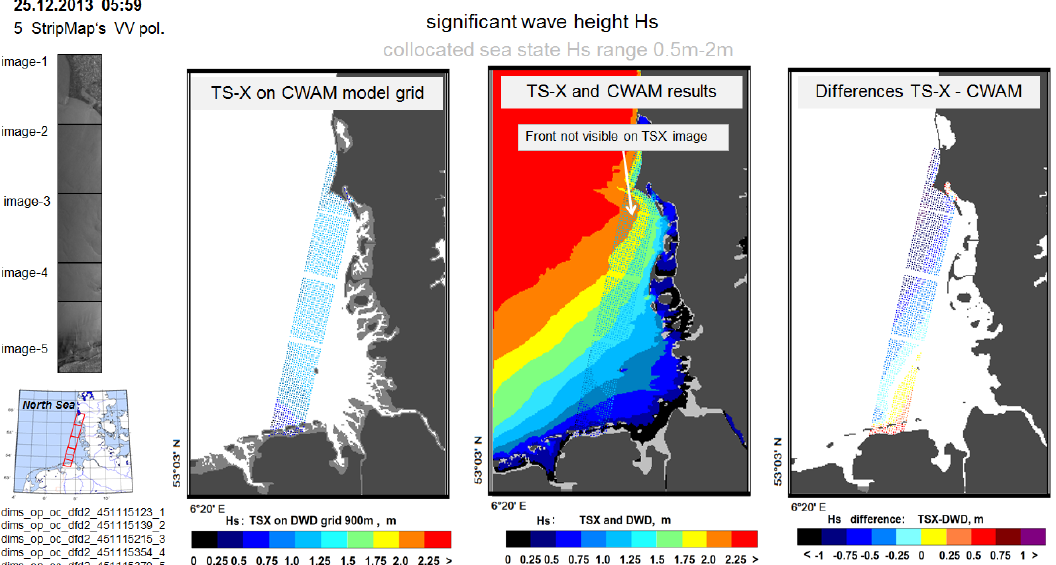
Figure 12. Example of a spatial comparison of sea state derived using TerraSAR-X /XWAVE_C with the CWAM model results. The coastal model shows a front with Hs >2.25m, which is not visible in TS-X data. The comparison of local wind shows also differences: